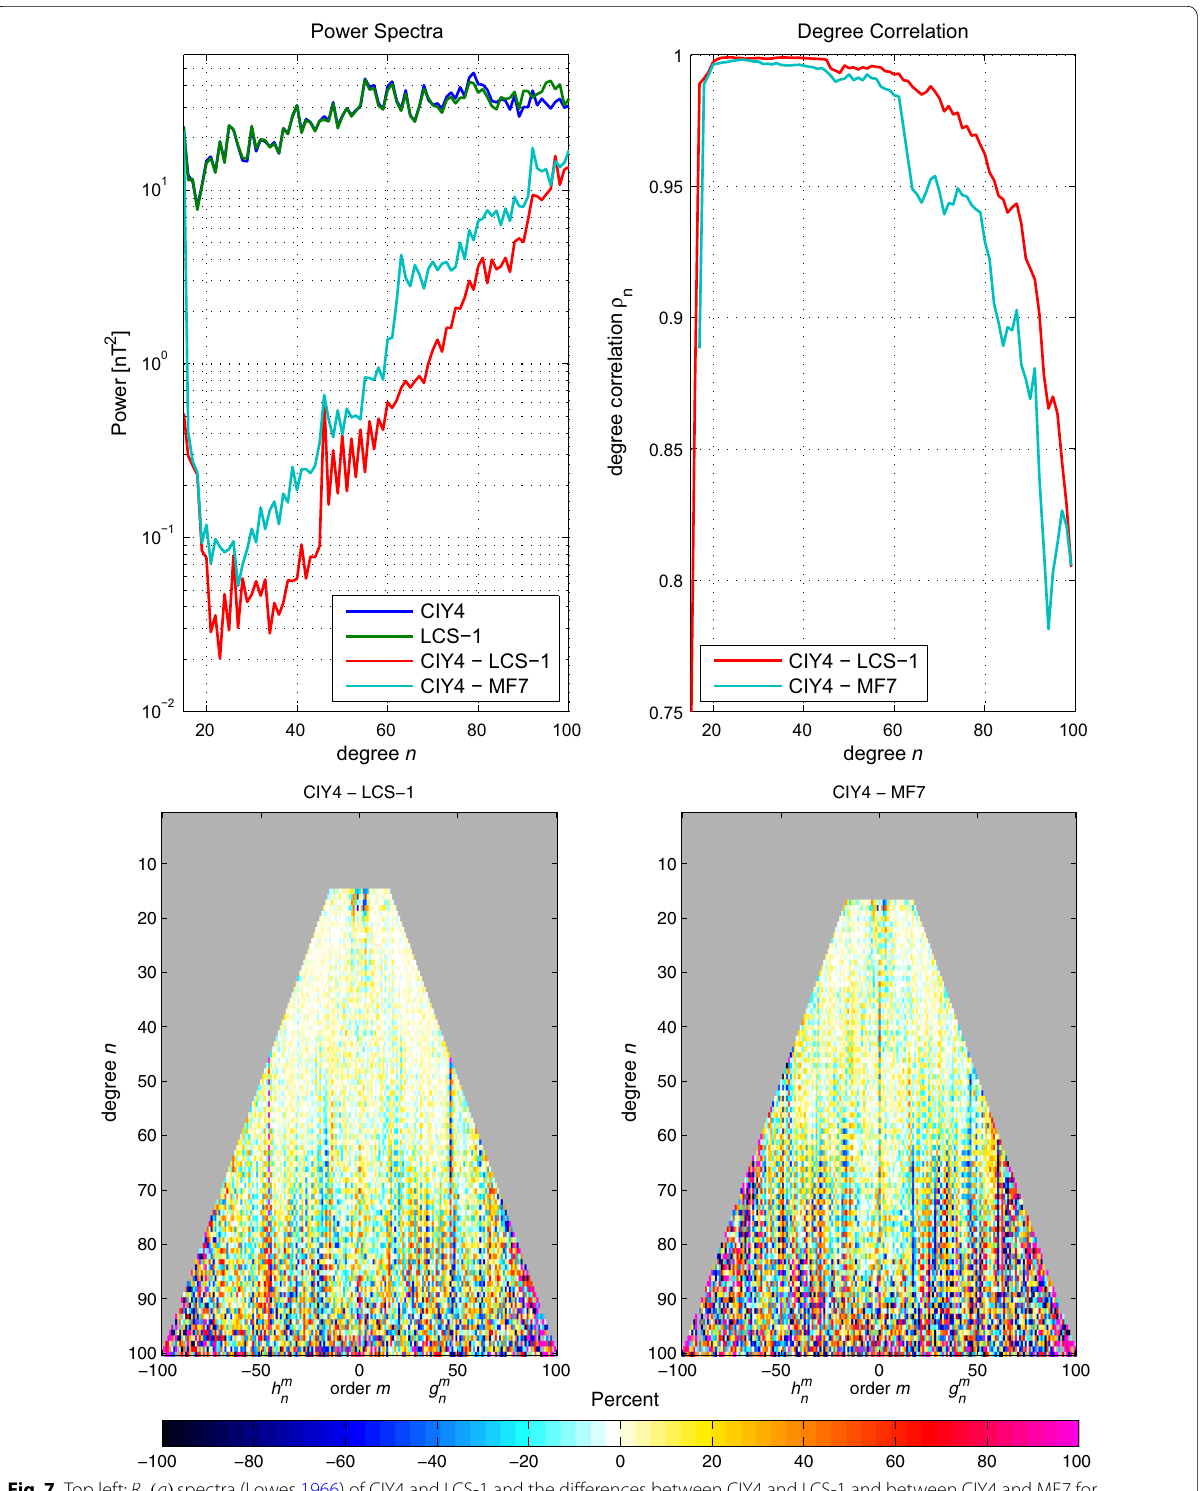
Fig. 7 Top left: R n ( a ) spectra (Lowes 1966) of CIY4 and LCS‑1 and the differences between CIY4 and LCS‑1 and between CIY4 and MF7 for a = 6371.2km . Top right: degree correlations ρ n between CIY4 and LCS‑1 and CIY4 and MF7. Bottom: matrices of normalized coefficient differences, S ( n , m ), of CIY4 with respect to LCS‑1 and MF7. All plots are for SH degrees n = 15 − 100 at epoch